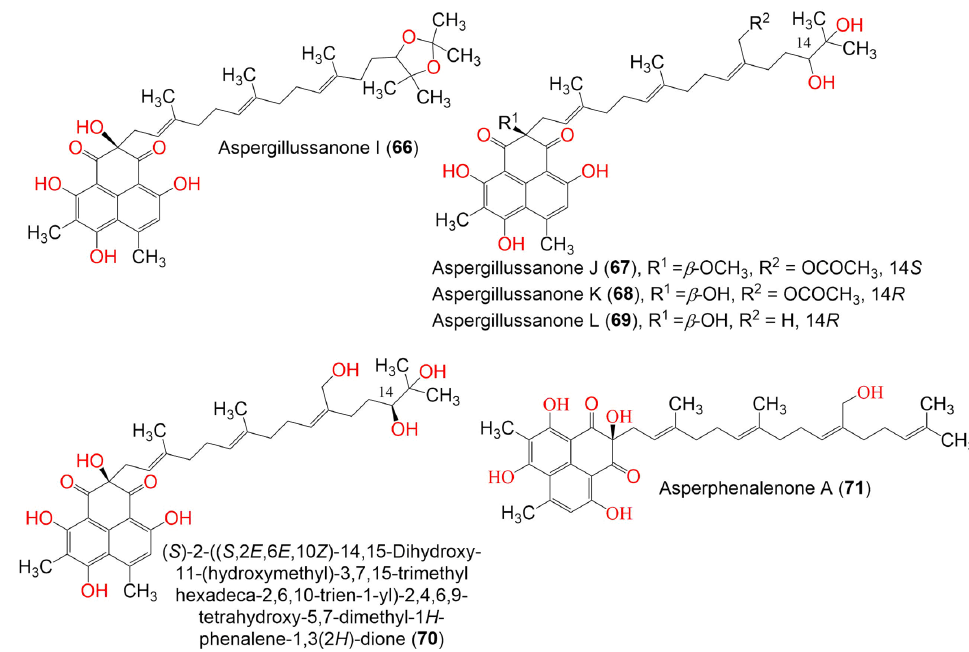
Figure 7. The structures of compounds 66–71 .